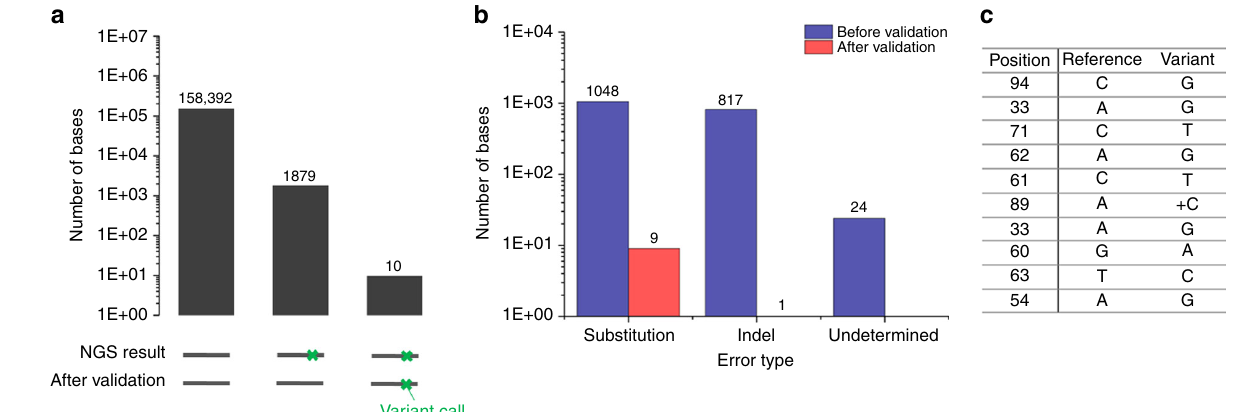
Fig. 2 NGS error veri fi cation of sequence-known DNA sample. a Miscalled base errors validation through a known-sequence template sequencing. Out of total variants (1889) called, 99.58% (1879) was miscalled bases, and 0.15% (10) was true variants. b Comparison of variants counts before and after the barcode-free NGS error validation according to error type. c True variants expected by the barcode-free NGS error validation method; the 10 variants (0.53% of the variant call) were in both of 454 and validation sequencing result that the DNA damage caused. Source data are provided as a Source Data fi